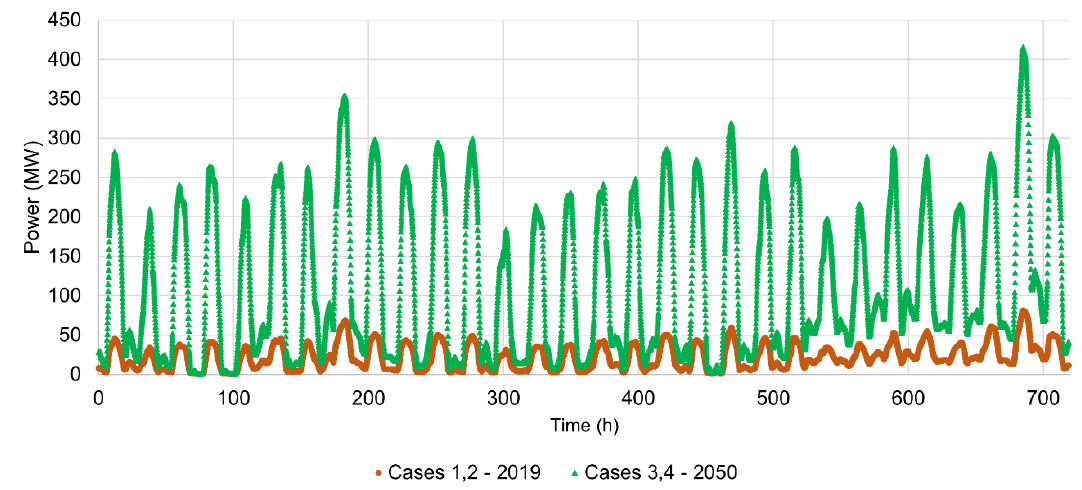
Figure 8. 2019 and 2050 variable renewable energy penetrations (solar/wind).